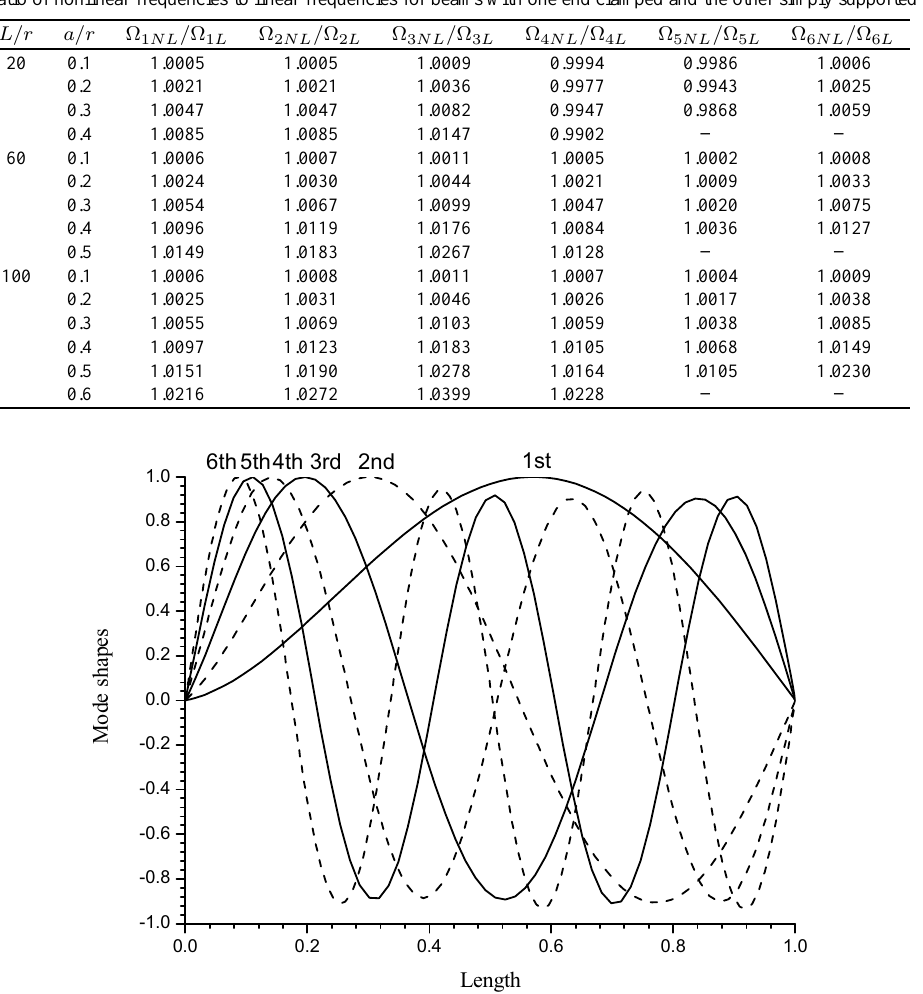
Table 4 Ratio of nonlinear frequencies to linear frequencies for beams with one end clamped and the other simply supported